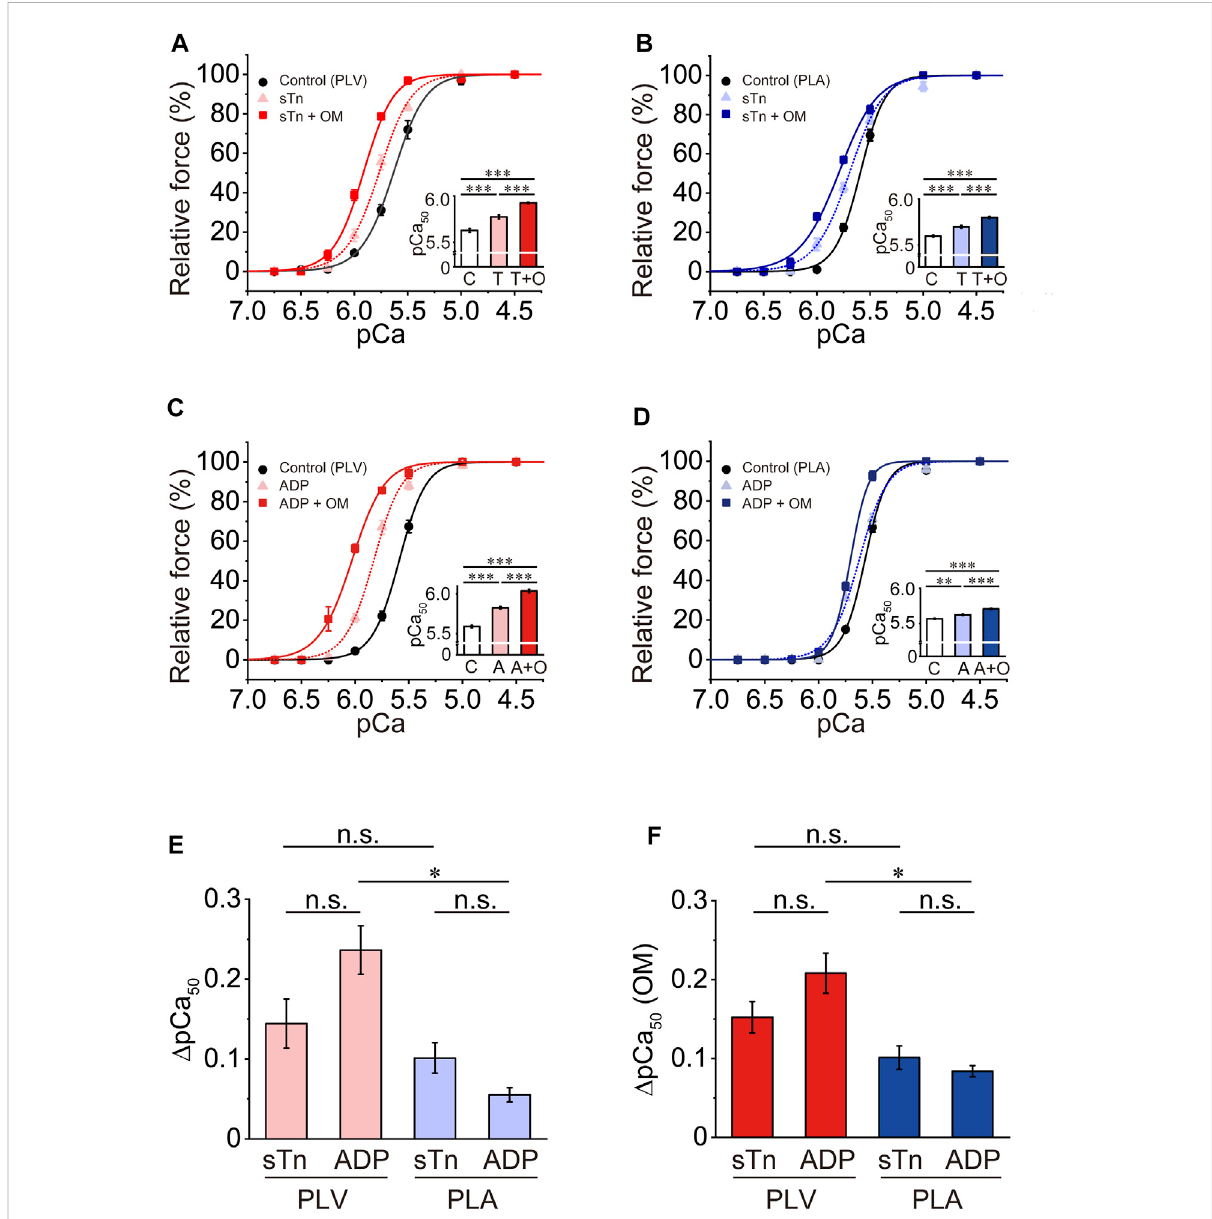
FIGURE 4 EffectsofOMonCa 2+ sensitivityinPLVandPLAunderenhancedactivationcondition. (A) Force-pCacurvesshowingtheeffectof1.0 μ MOMon Ca 2+ sensitivity in PLV following sTn treatment. Black circles and solid lines, control (before sTn treatment); light red triangles and dotted lines, after sTn treatment; red squares and solid lines, 1.0 μ M OM after sTn treatment. Inset, pCa 50 valuesindicating Ca 2+ sensitivity under varying conditions. C, control(withoutOM);T,sTntreatment;T+O,1.0 μ MOMaftersTntreatment.*** p < 0.001(Tukey-Kramertest). n =6forallgroups. (B) Sameas in (A) for PLA showing the effect of 1.0 μ M OM on Ca 2+ sensitivity following sTn treatment. Black circles and solid lines, control (before sTn treatment); light blue triangles and dotted lines, after sTn treatment; blue squares and solid lines, 1.0 μ M OM after sTn treatment. Inset, pCa 50 values under varying conditions. C, control (without OM); T, sTn treatment; T + O, 1.0 μ M OM after sTn treatment. *** p < 0.001 (Tukey-Kramer test). n = 5 for all groups. (C) Force-pCa curves showing the effect of 1.0 μ M OM on Ca 2+ sensitivity in PLV following 3 mM MgADP application. Black circles and solid lines, control (before MgADP application); light red triangles and dotted lines, after MgADP application; red squares and solid lines, 1.0 μ M OM after MgADP application. Inset, pCa 50 values under varying conditions. C, control (without OM); A, MgADP application; A + O, 1.0 μ M OM after MgADP application. *** p < 0.001 (Tukey-Kramer test). n = 4 for all groups. (D) Same as in (A) for PLA showing the effect of 1.0 μ M OM on Ca 2+ sensitivity following 3 mM MgADP application. Black circles and solid lines, control (before MgADP application); light blue triangles and dotted lines, afterMgADPapplication;bluesquaresandsolidlines, 1.0 μ MOMafter MgADPapplication.Inset,pCa 50 undervaryingconditions.C,control(without OM); A, MgADP application; A + O, 1.0 μ M OM after MgADP application. ** p < 0.01; *** p < 0.001 (Tukey-Kramer test). n = 5 for all groups. (E) Graph showing the increased Ca 2+ sensitivity ( Δ pCa 50 ) following sTn treatment (sTn) vs. MgADP application (ADP) in PLV and PLA. * p < 0.05 (unpaired Student ’ st test).Data obtained from (A – D) . (F) Graph showing the Ca 2+ -sensitizing effect of 1.0 μ M OM [ Δ pCa 50 (OM)] following sTn treatment (sTn) vs. MgADP application (ADP) in PLV and PLA. * p < 0.05 (unpaired Student ’ s t test). Data obtained from (A – D)